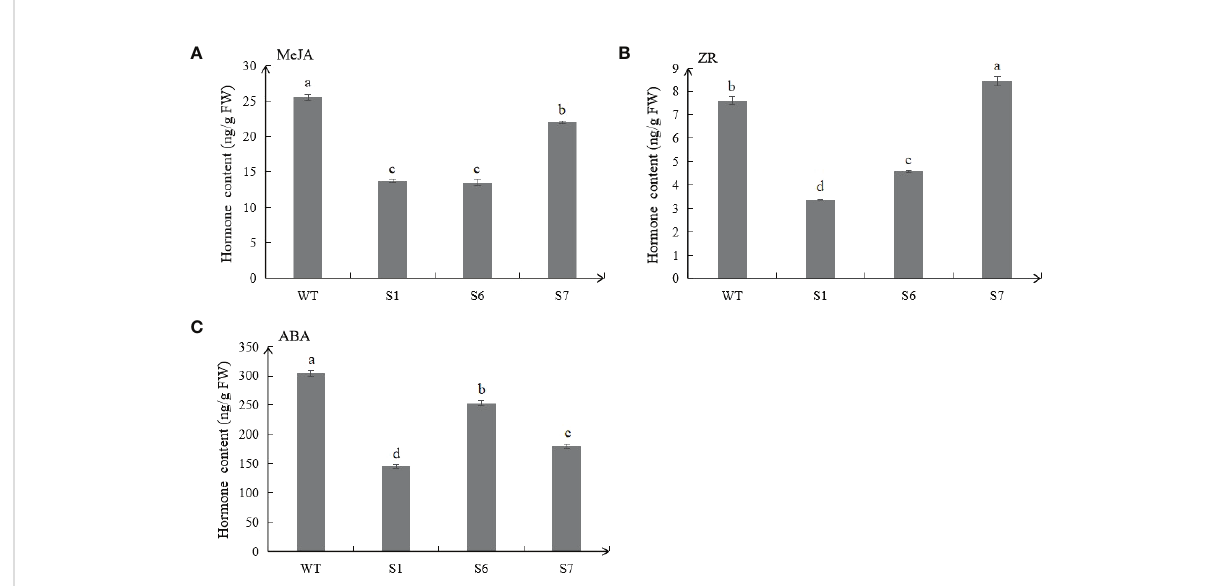
FIGURE 5 Endogenous hormone contents in transgenic and WT plants. Different hormones, including MeJA (A) , ZR (B) and ABA (C) contents in transgenic and WT plants.The values are means ± SD (n = 3). In graphs, bars with different lowercase letters indicate signi fi cant difference at